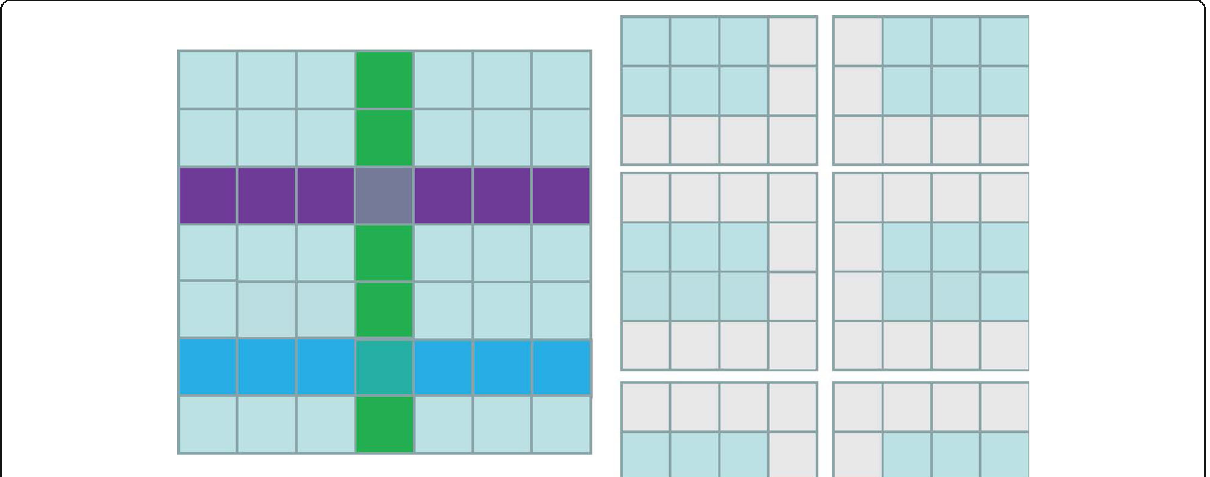
Fig. 3 An example of region partition. We mark the extracted grids with different colors (the left) that will be incorporated into their adjacent parts as the boundaries. The order of grid extraction is green, purple, and blue; in the end, the scene is divided into several overlapping chunks (the